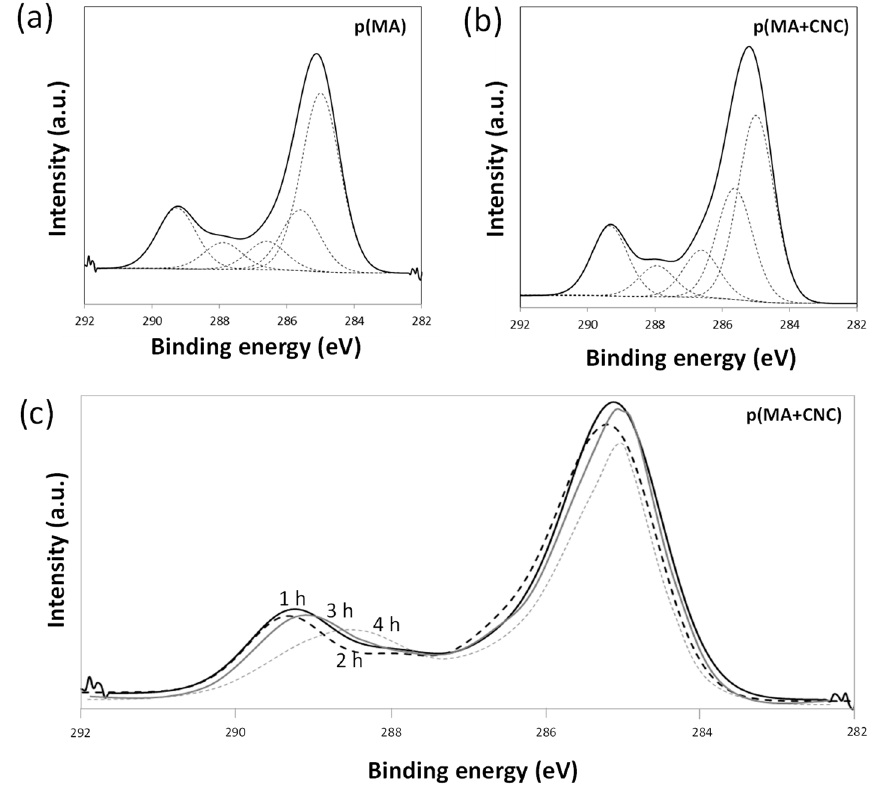
Figure 5. XPS spectra for ( a ) pure p(MA) film before hydrolysis with deconvolution in different components, ( b ) p(MA+CNC) nanocomposite film before hydrolysis with deconvolution in different components, ( c ) p(MA+CNC) nanocomposite films after different hydrolysis